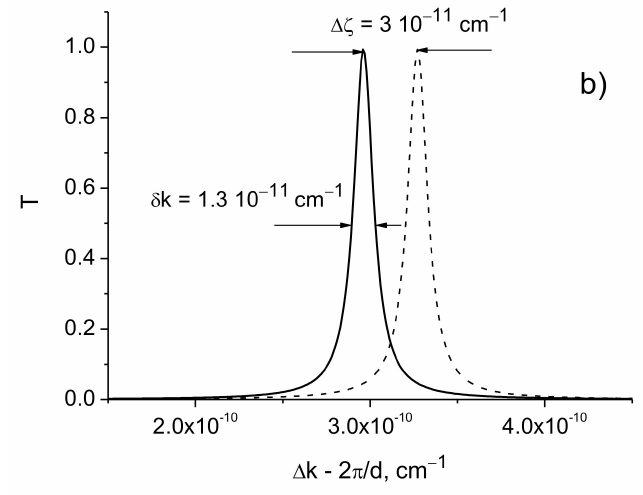
Figure 8. Transmission coefficient as function of the detuning of the resonator: ∆ ε = 1.5 · 10 − 4 , λ = 630 nm, L = 0.75 cm, d = 1 m, ∆ d = 5 · 10 − 8 cm. ( a ) m = 0; ( b ) m = 1, solid curve corresponds to the distance d = 1 m, dashed curve corresponds to the distance d + ∆ d